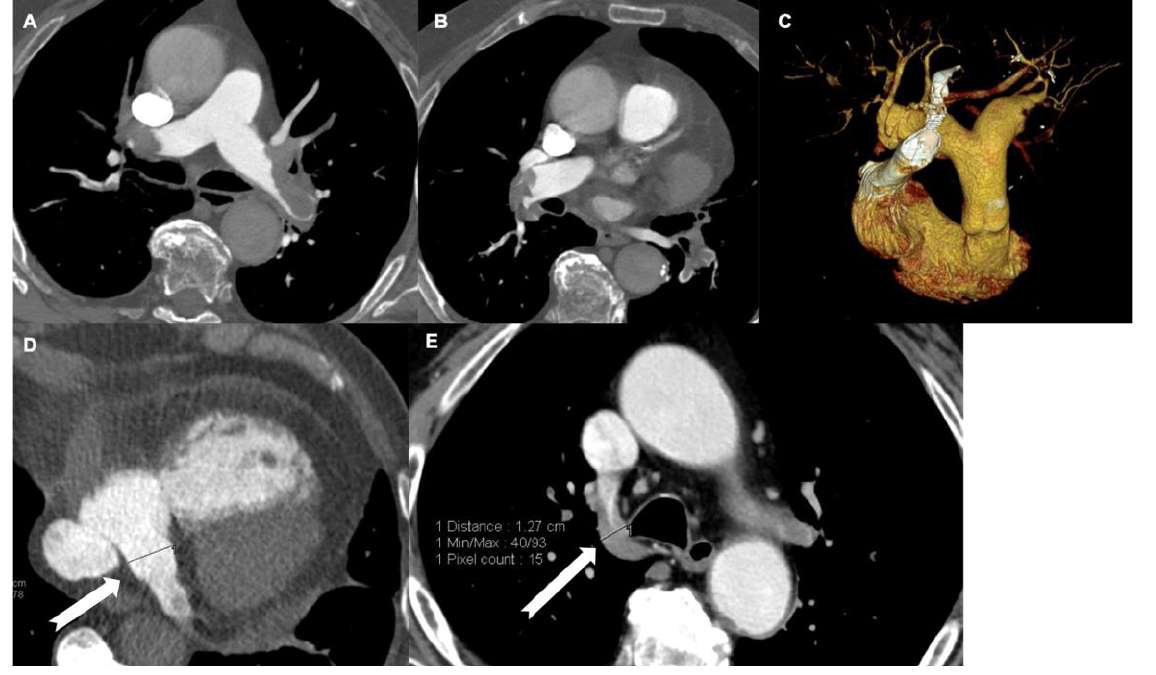
Figure 3. Increase in the diameter of the veins and embolism. A middle-aged man with huge eccentric emboli attached to the vascular wall of both pulmonary arteries ( A – C ). ( D ) Dilatation of the